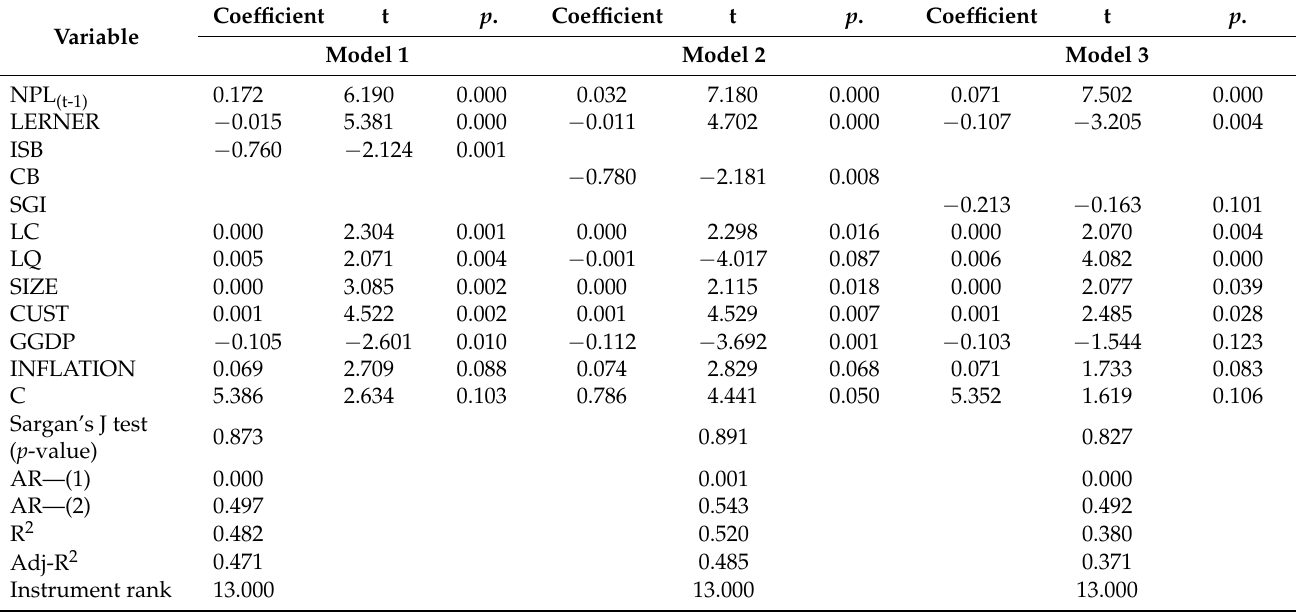
Table 5. Effects of competition (based on the Lerner index), loan quality and ownership structure on credit risk.